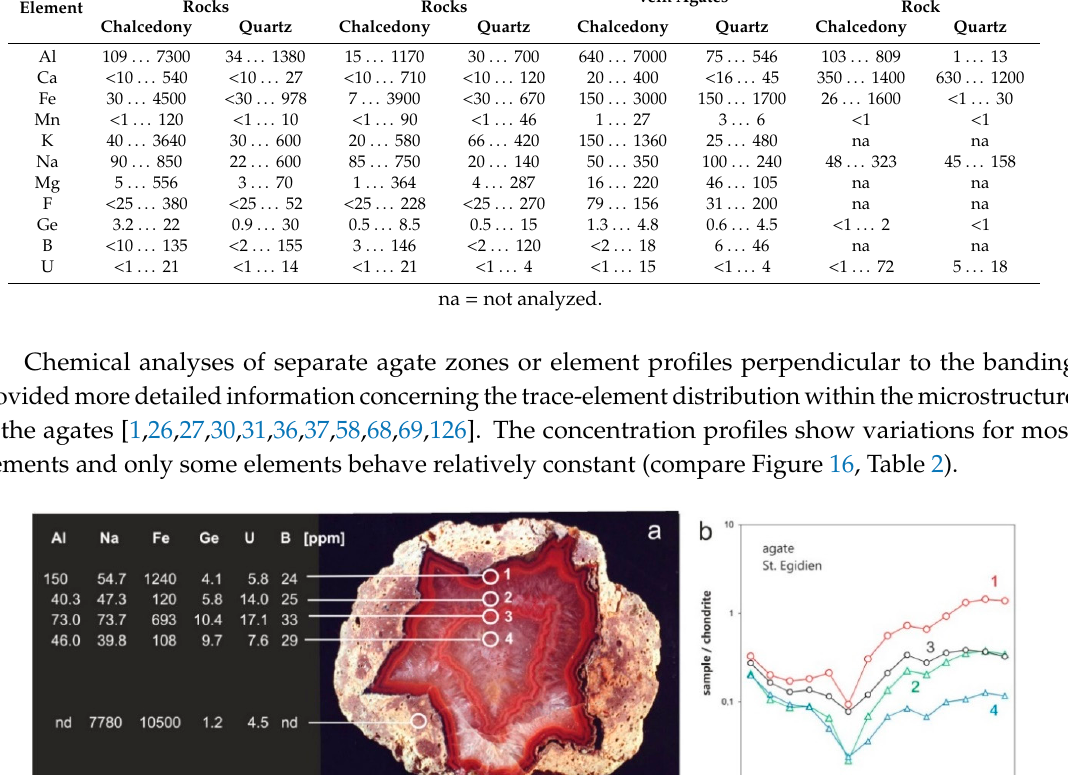
Table 1. Variations of selected trace-element concentrations (in ppm) of chalcedony and macrocrystalline quartz in agates of different origin (data from [1,26,27,30,31,36,37,58,68,69,126]). Agates in Acidic Volcanic Rocks Agates in Basic Volcanic Rocks Vein Agates Element